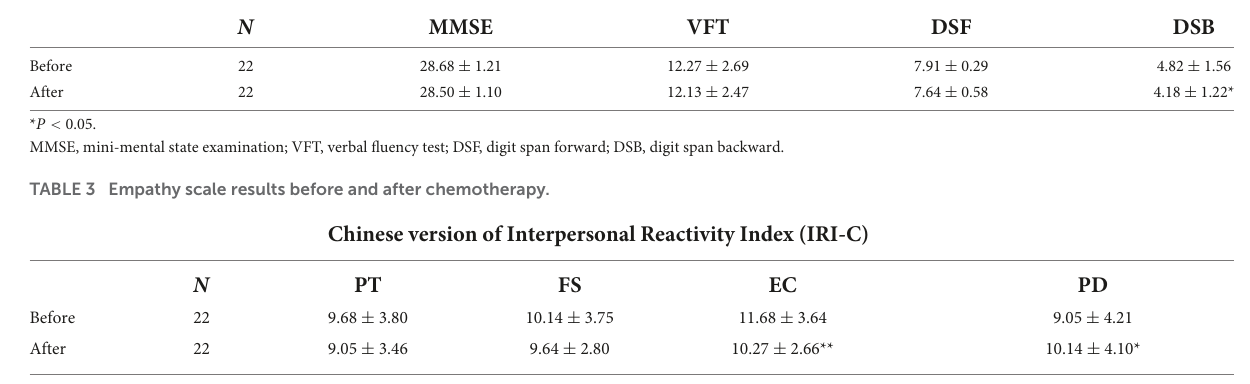
TABLE 2 The performance of neuropsychological tests before and after chemotherapy.